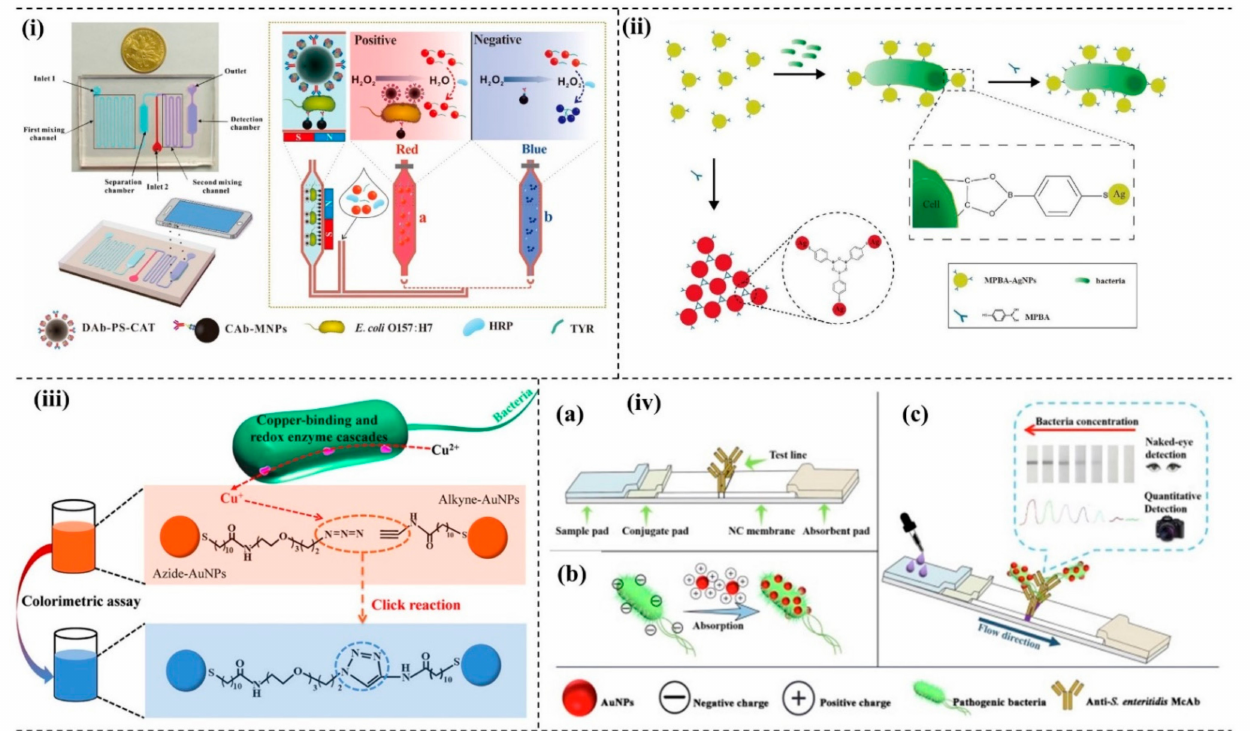
Figure 2. Metallic nanomaterials-based pathogen detection system: ( i ) E. coli O157:H7 is detected by tuning the optical property of AuNPs by using tyramine as a crosslinking agent in microfluidic platform. Reprinted with permission from Ref. [97]. Copyright 2019 Elsevier. ( ii ) Colorimetric detec- tion of bacteria explores the aggregation and inhibition of aggregation of MPBA-AgNPs. Reprinted with permission from Ref. [98]. Copyright 2018 Elsevier. ( iii ) Aggregation of AuNPs is instructed by bacteria to undergo click chemistry and triggered in the presence of Cu + . Reprinted with permission from Ref. [99]. Copyright 2019 American Chemical Society. ( iv ) Schematic representation of the colorimetric assay of S. enteritidis based on positively charged AuNPs using lateral flow technology, ( a ) test strip structure, ( b ) interaction of (+) AuNPs- ( − ) S. enteritidis mechanism, ( c ) colorimetric and quantitative detection of S. enteritidis